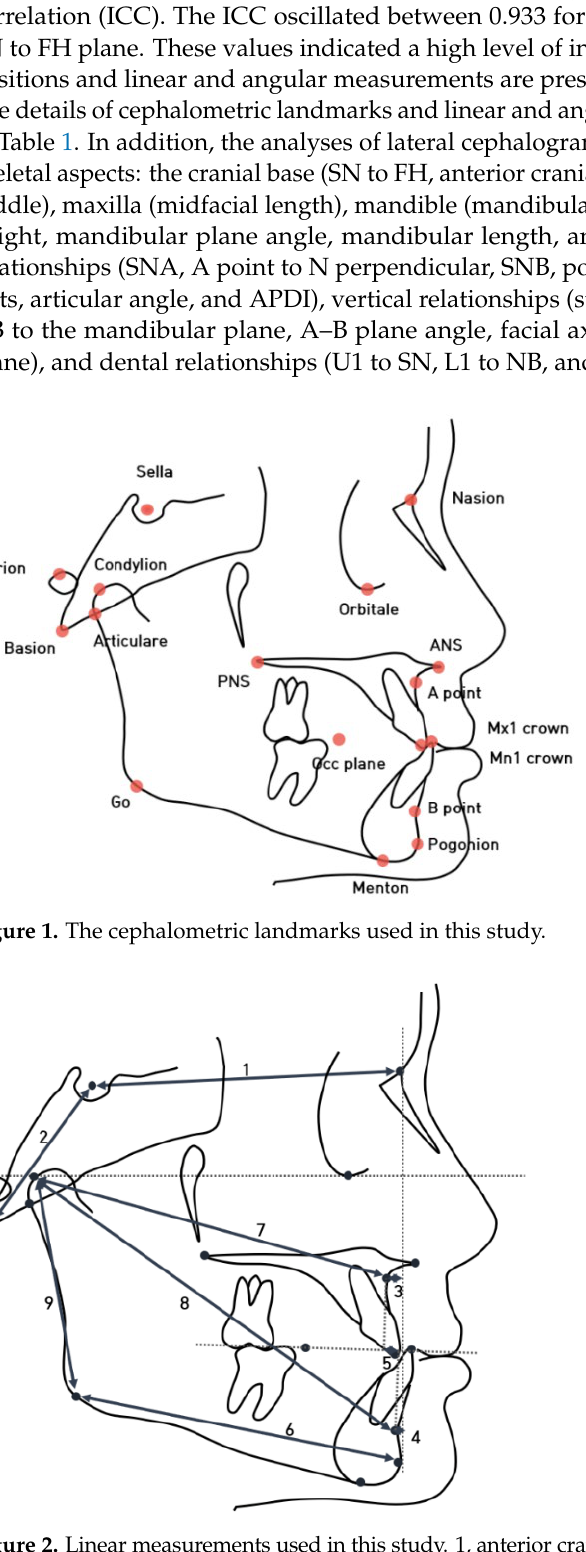
Figure 3. Angular measurements used in this study. 1, SN to the FH plane; 2, SNA angle; 3, SNB angle; 4, ANB angle; 5, saddle angle; 6, articular angle; 7, gonial angle; 8, SN-GoGn; 9, AB to the mandibular plane; 10, A–B plane angle; 11, facial axis; 12, mandibular plane angle; 13, A-B to the occlusal plane; 14, inclination of upper incisor; and 15, inclination of lower incisor.